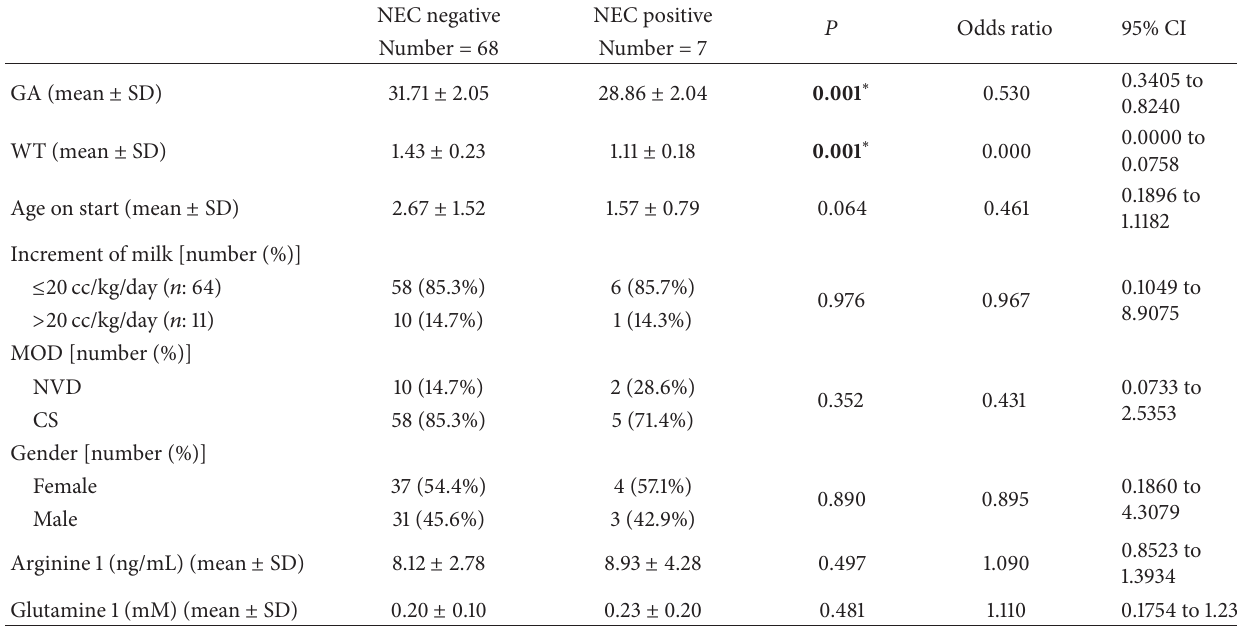
Table 2: Comparison between NEC negative and NEC positive patients.